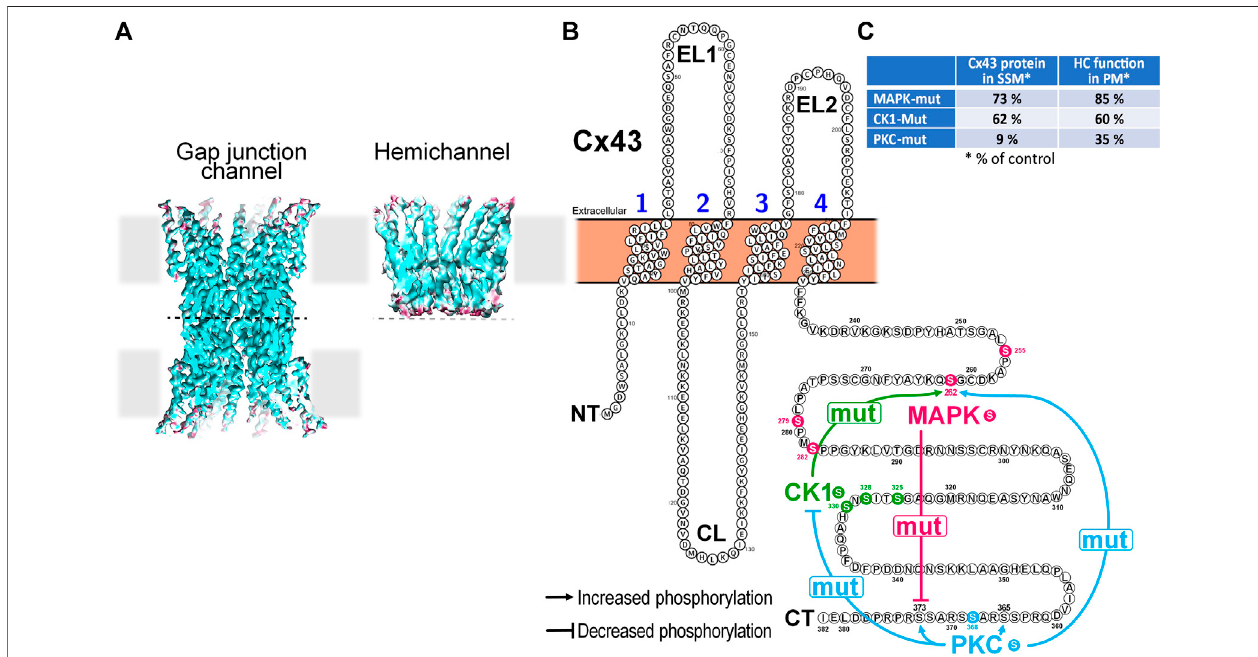
FIGURE 1 | Impact of mutation of Cx43 phosphorylation sites targeted by MAPK, CK1 or PKC on the phosphorylation state of non-targeted residues in mitochondrialCx43anditsconsequencesforhemichannelfunctionandmitochondrialCx43presenceincardiomyocytes. (A) Cryo-EMreconstructionsofaCx26-based gap junction channel and hemichannel (3.5 to 4.2 Å resolution). Hemichannels are hexameric channels composed of six subunits, while a gap junction channel results from the head-to-head docking of two hemichannels on neighboring cells. (Illustration from (Khan et al., 2021)). (B) Membrane topology of a Cx43 monomer illustrating cross-effects of mutation of selected Cx43 amino acid residues on other phosphorylation sites within the same protein. Mutation of the 4 MAPK Ser residues to Ala (mut) reduces phosphorylation at S373, a residue targeted by Akt/PKB. Mutation of S325A, S328Y, and S330A of CK1 increases the phosphorylation at S262, a residuetargeted byMAPK. PKCS368Amutationhad mostextensive effects.Itreducedphosphorylationatall3sitestargeted byCK1butenhanced phosphorylationat S262targetedbyMAPK,S365thatisindirectlytargetedbyPKAandS373targetedbyAkt/PKB. (C) TablesummarizingtheimpactofmutationofCx43phosphorylation sites targeted by MAPK, CK1 or PKC on the presence of Cx43 protein in SSM and the function of hemichannels as assessed in the plasma membrane (PM).